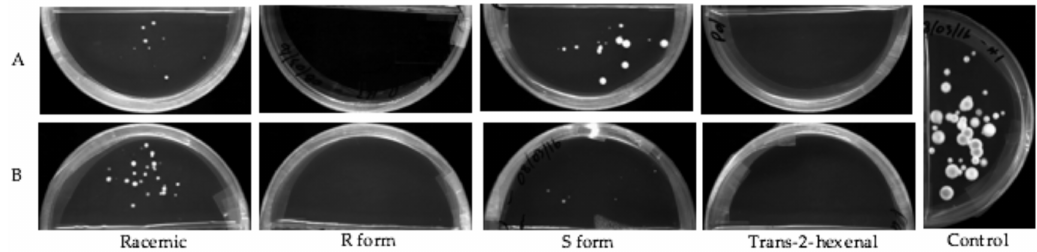
Figure 5. The effect of exposure to low concentrations of volatilized racemic 1-octen-3-ol, ( R )-( − )-1-octen-3-ol ( R form), ( S )-(+)-1-octen-3-ol ( S form) and trans -2-hexenal on growth of P. destructans conidiospores after 3 weeks of incubation at 10 ◦ C. VOC treatments as follows: